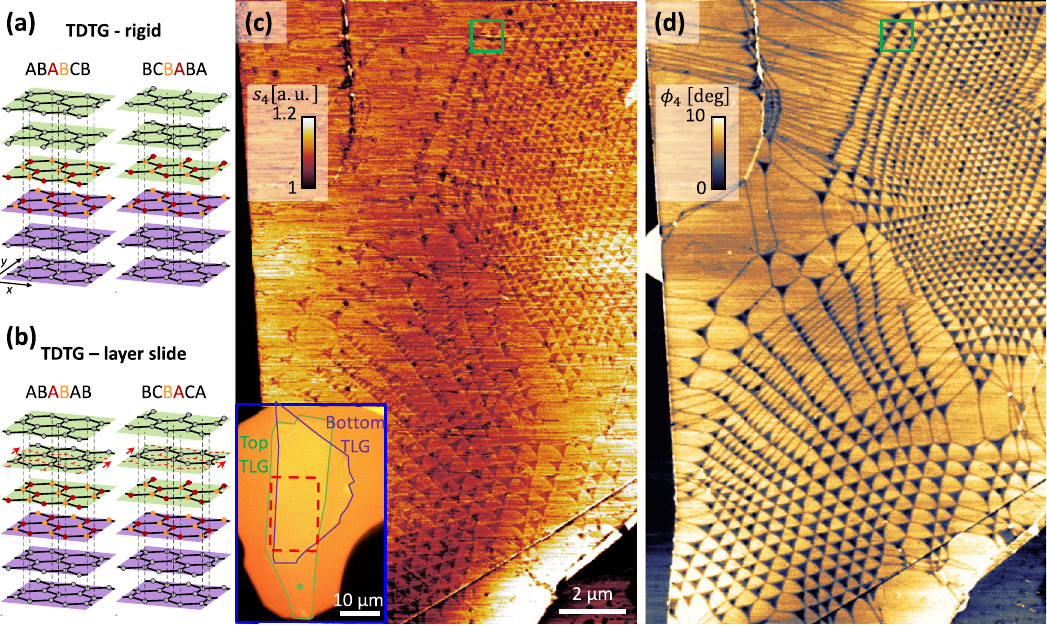
Fig. 1 | Moiré superlattice of twisted double trilayer graphene (TDTG). a The lattice structure of the two lowest energy stacking con fi gurations of TDTG when assuming both top and bottom trilayer graphene (TLG) are Bernal stacked. The interfacialatomsare colored to highlight the AB/BAstacking con fi gurations. b The TDTG system after a global slide of the middle layer of one of the TLG sheets. The direction of slide is marked by red arrows indicating the transition from an ABA (dashed red honeycomb lattice) to a BAB con fi guration. Such a slide, if realized,